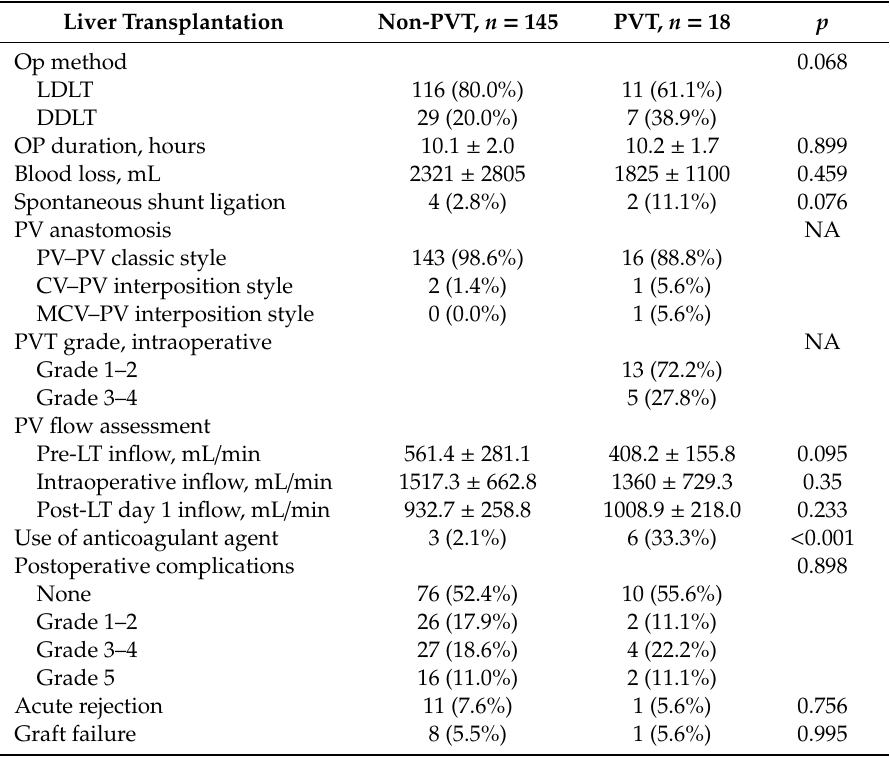
Table 3. Clinical characteristics of the patients with liver